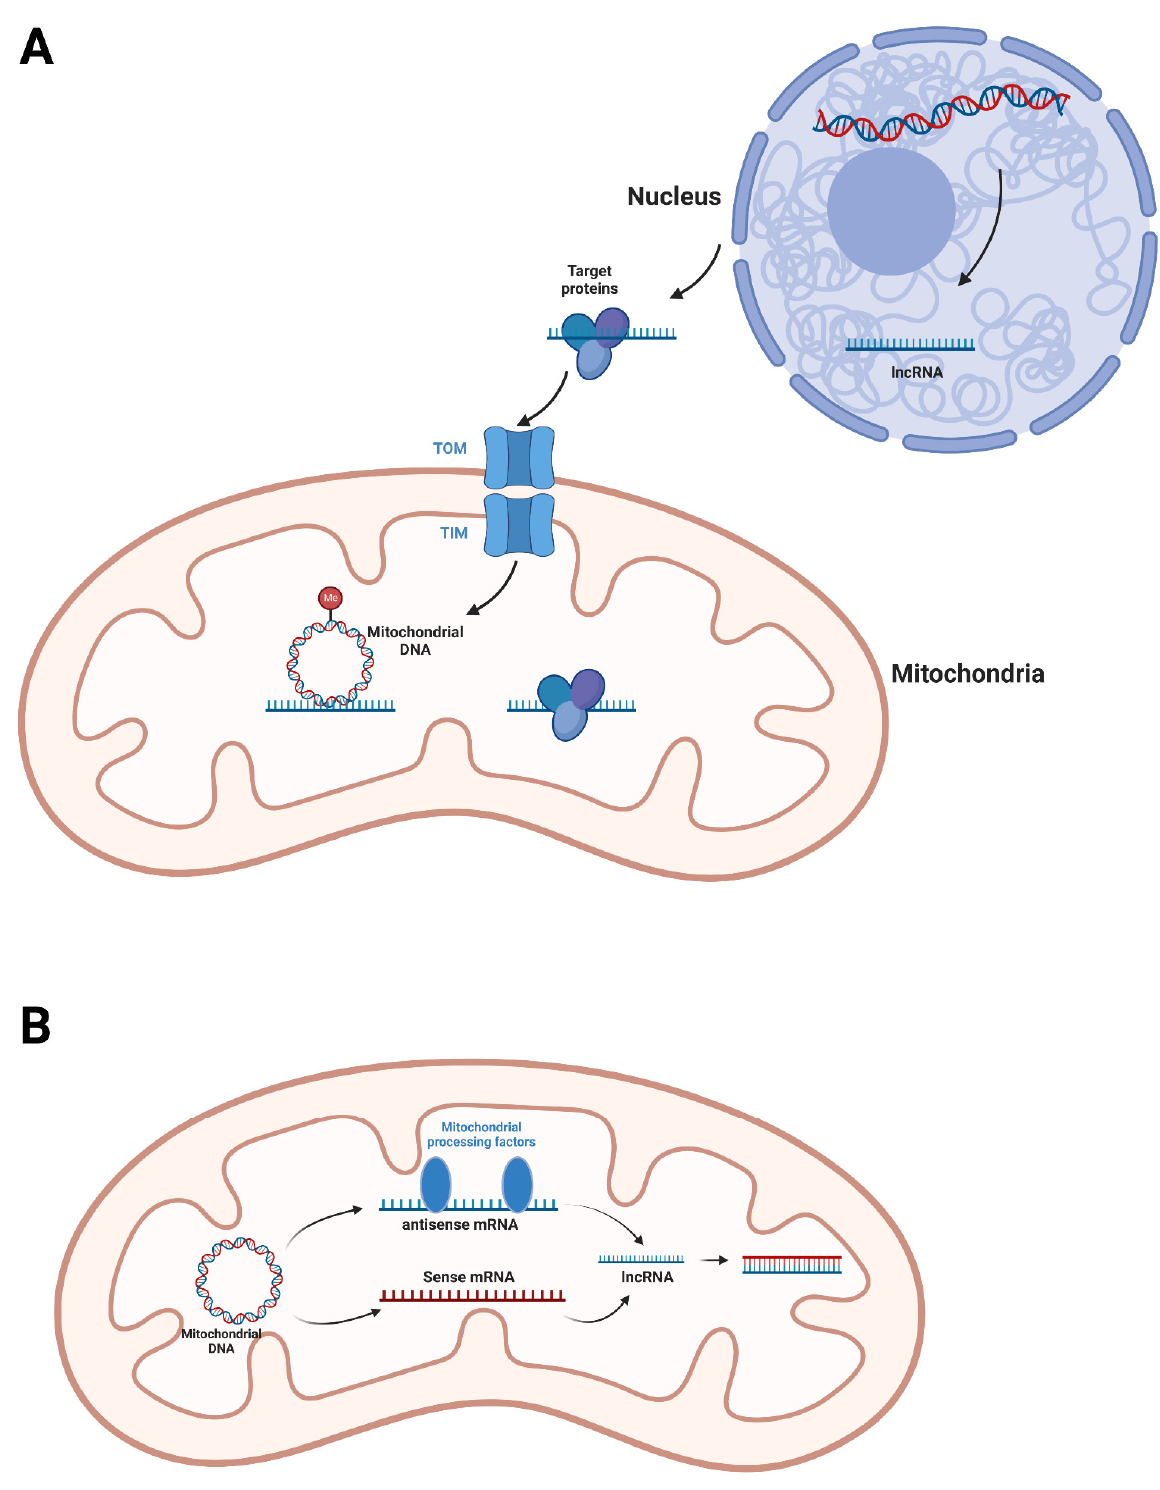
Figure 2. The biogenesis, translocation and function of nuclear genome-encoded mitochondrial lncRNAs ( A ) and mitochondrial genome-encoded lncRNAs ( B ). ( A ) The mitochondrial translocation of nuclear genome-encoded mitochondrial lncRNAs might be correlated with associated nuclear-genome-encoded mitochondrial proteins. These lncRNAs were discovered to function via binding proteins, as well as interact with mitochondrial DNA to affect DNA methylation. ( B ) Mitochondrial genome-encoded lncRNAs might be processed by processing factors of mitochondrial tRNAs, such as MRPP1. They complementally interact with the mRNAs to stabilize the